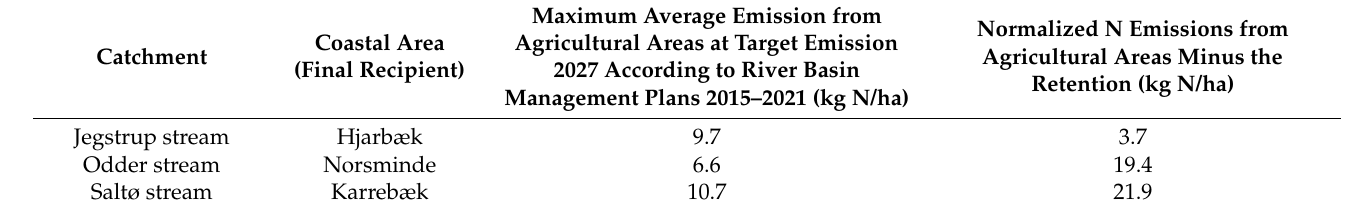
Table 2. Target fulfillment for 2027 in the three final recipients of the three study streams based on the Danish river basin management plans 2015–2021 [9,56,57]. Calculated normalized N emission from the agricultural areas minus the surface water retention for the reference period 2000–2015 is also given. Modified from